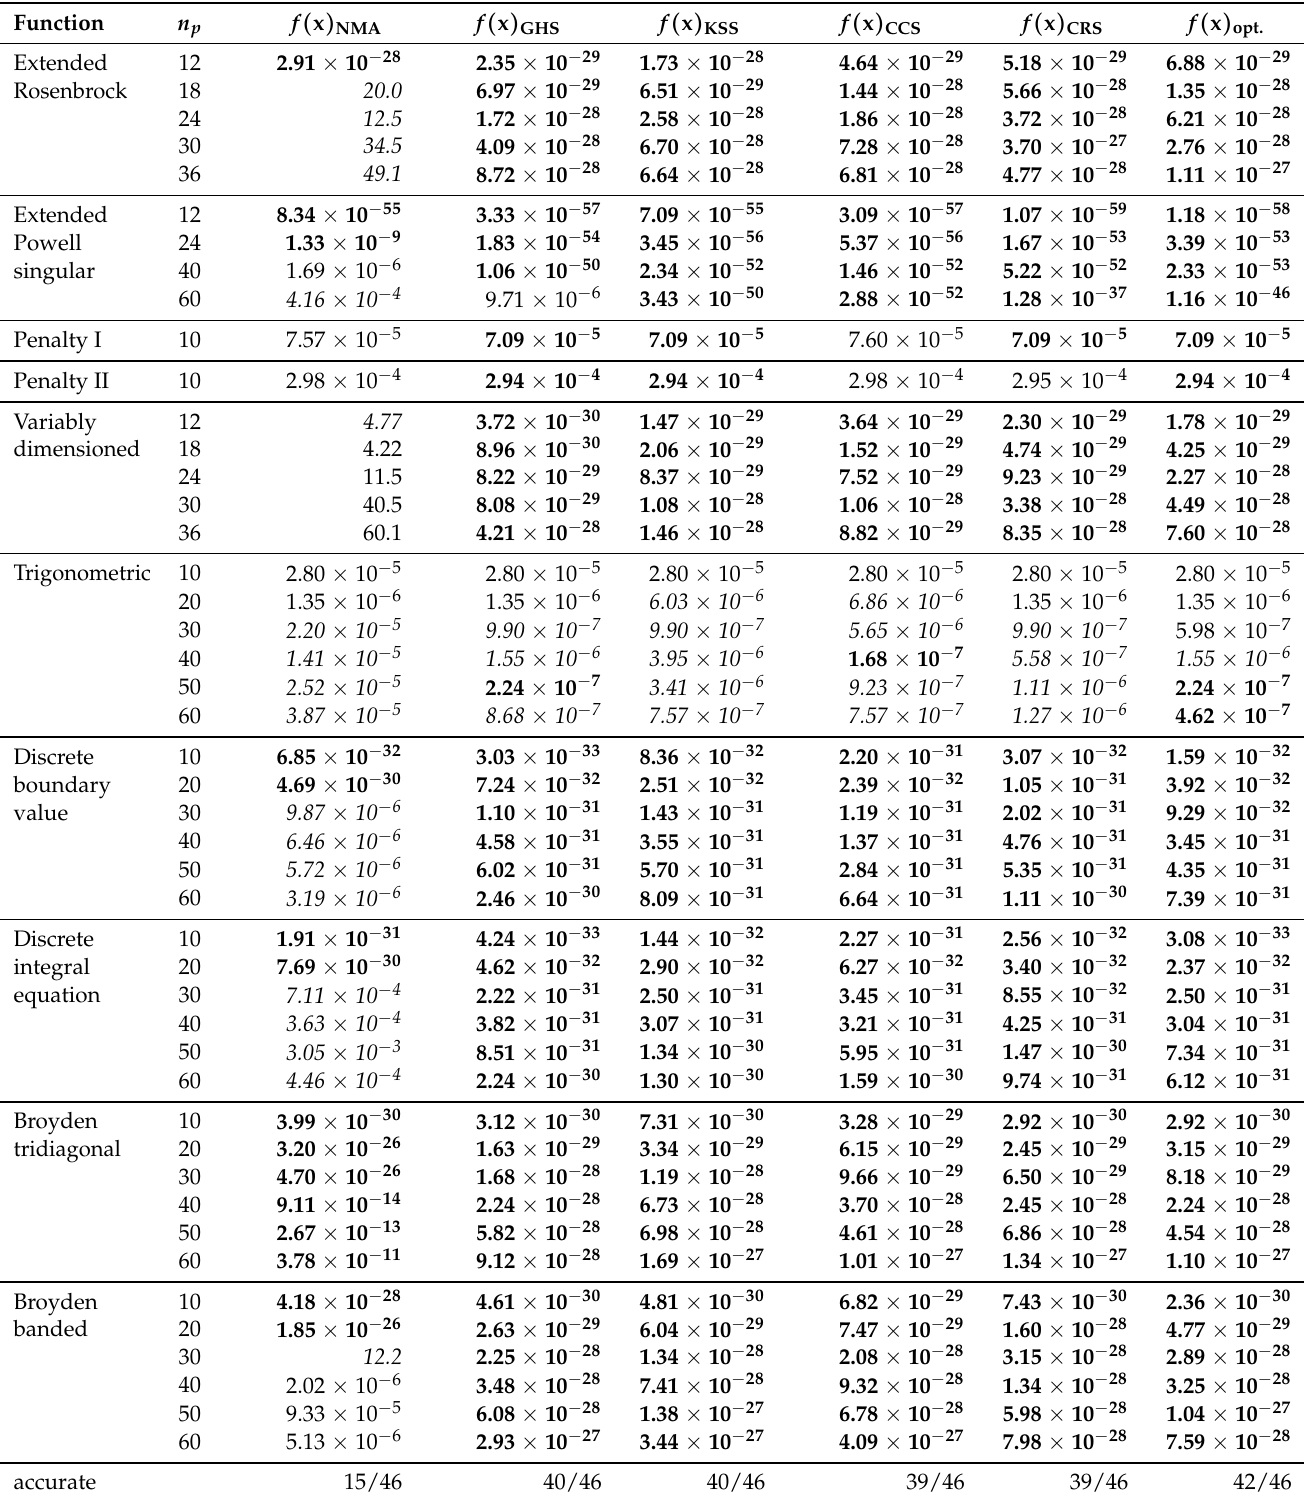
Table 2. Accuracy of the original NMA, the existing adaptive schemas (GHS, KSS, CCS, CRS), and the optimized schema on Moré–Garbow–Hilstrom (MGH) benchmark